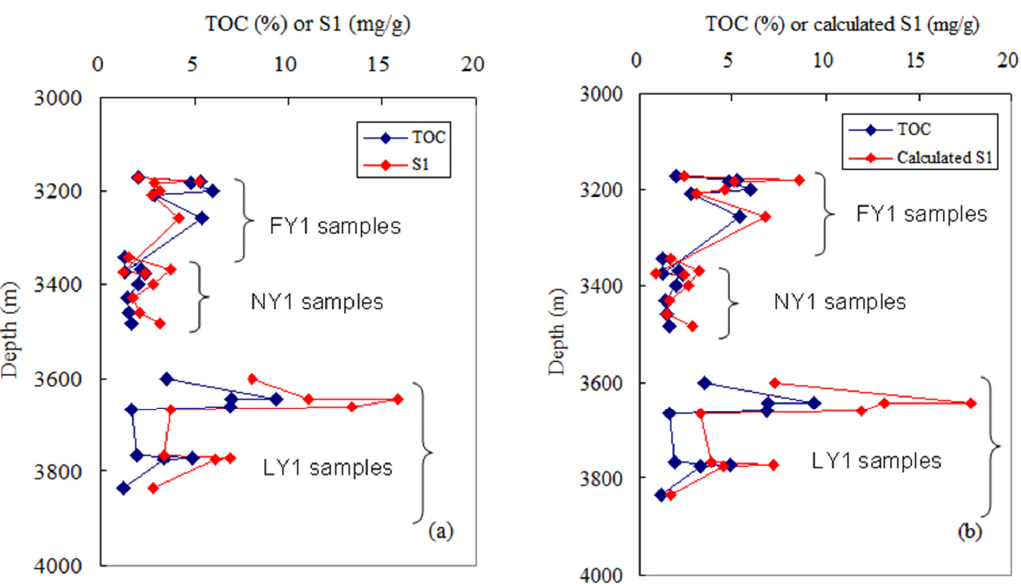
Figure 16. Relationship between EOM and S1 ( a ) and relationship between S1/TOC and EOM/TOC ( b ) based on the data of the studied samples.